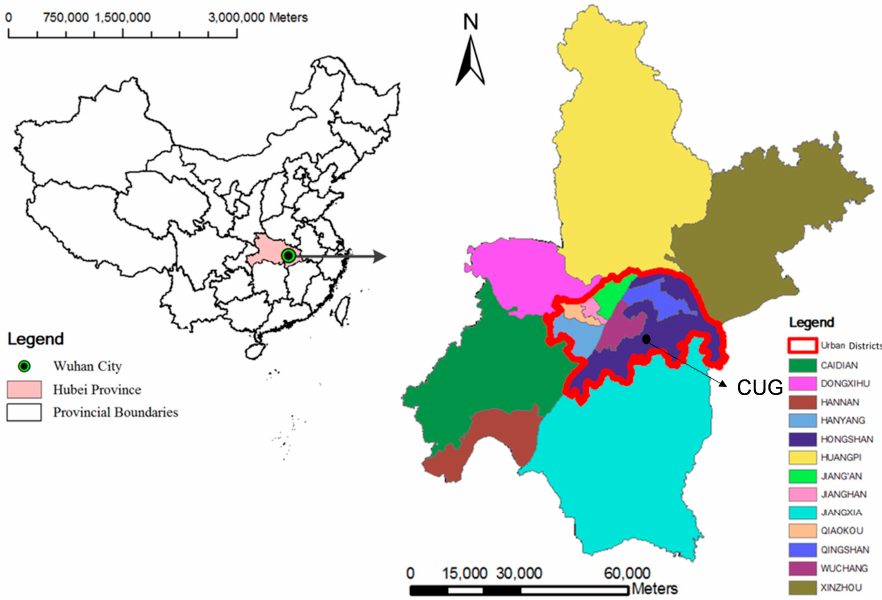
Figure 1. Location and administrative division of the study area.